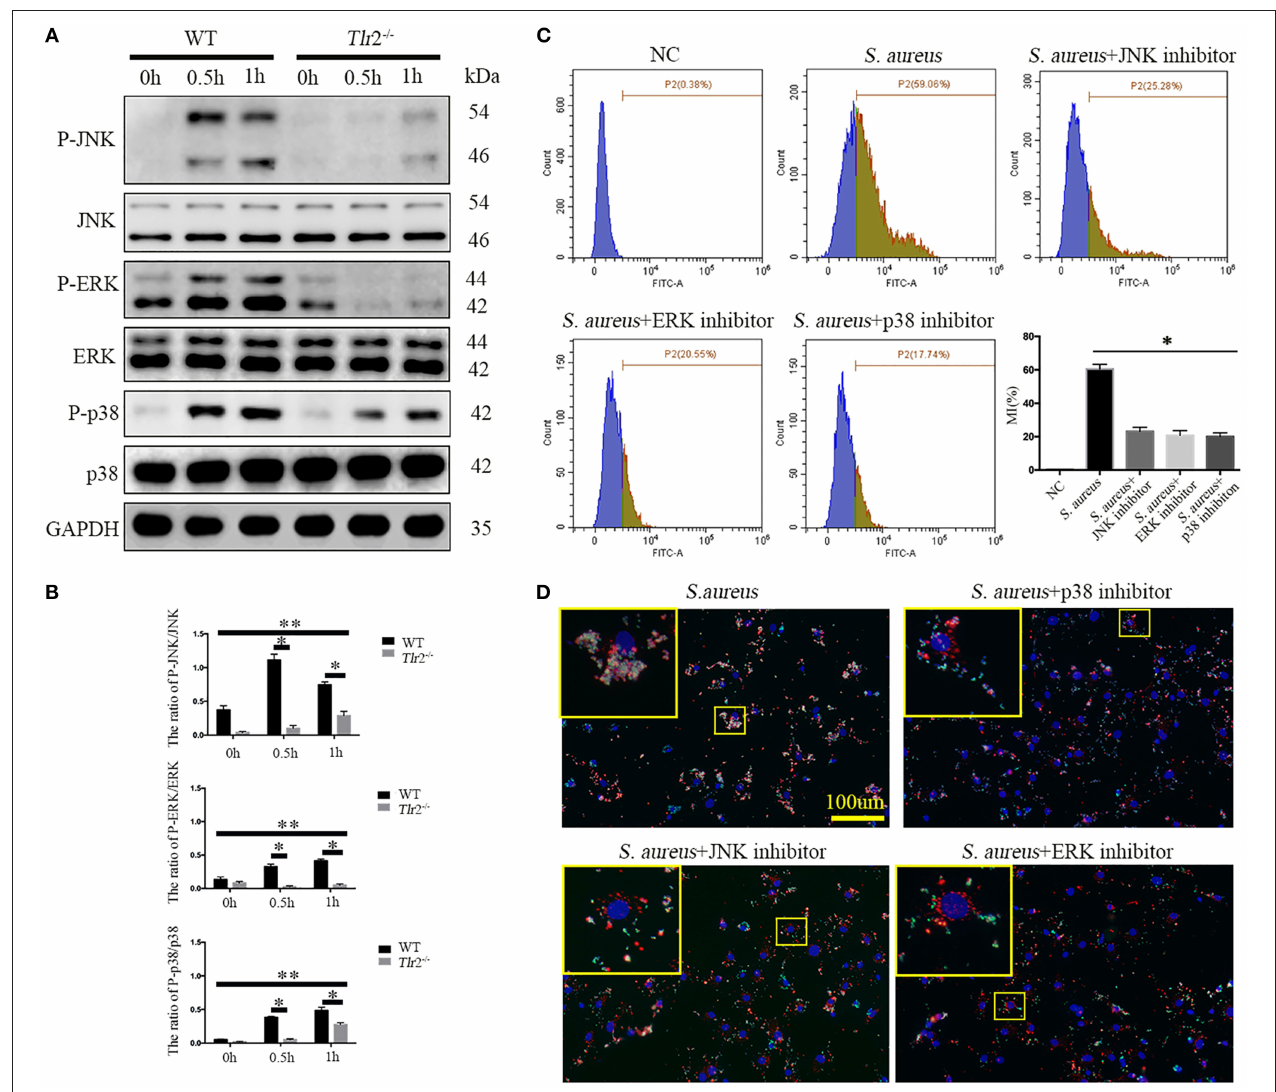
FIGURE 5 | MAPKs are the downstream pathway of TLR2 critical for phagocytosis and phagosome maturation of NPCs. (A,B) Western blot analysis of MAPKs (ERK, JNK, p-38) in NPCs from WT and Tlr2 − / − mice infected with S. aureus for different time periods. * P < 0.05, the group of WT vs. the group of Tlr2 − / − , ** P < 0.05, the different time point in WT group or Tlr2 − / − group. (C) FACS analysis to detect the interaction between NPCs and S. aureus with or without MAPKs specific inhibitors pretreatment. * P < 0.05, the S. aureus group vs. the different inhibitors group. (D) Co-localization of S. aureus and Lyso-Tracker Red was detected by fluorescence micrograph. P values were determined by T -test and one-way ANOVA. All data are presented as the means ± S.D from three independent